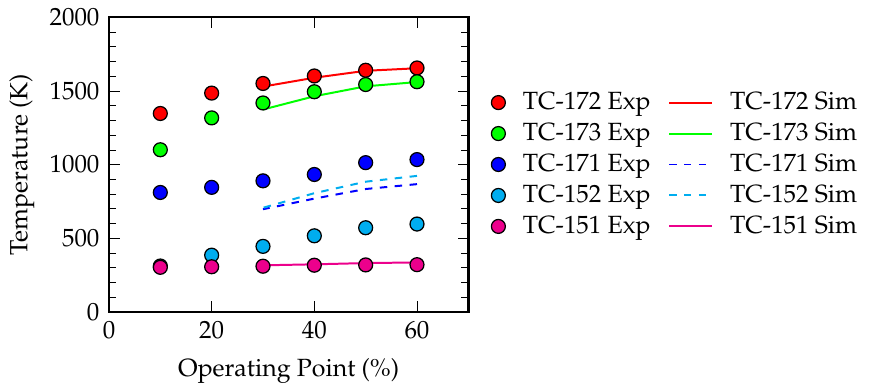
Figure 6. Comparison of the experimental and simulated thermocouple temperatures. Markers represent the experiment and lines the simulation. The simulation model has a high accuracy at values depicted with solid lines and deviations for the dashed